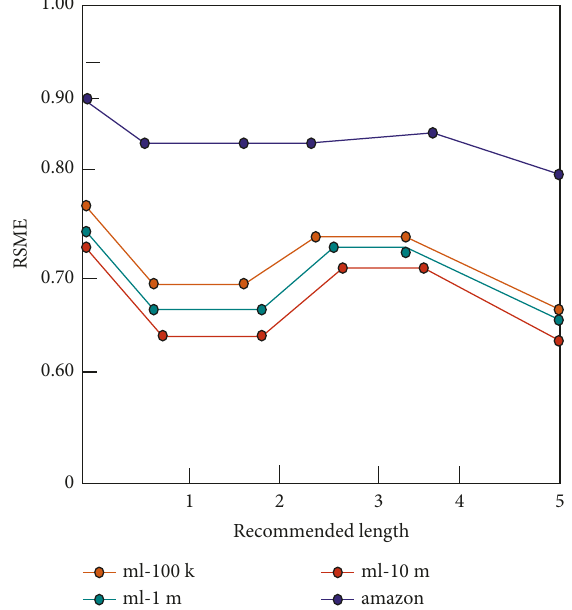
Figure 8: Effect of the number of hidden layers on RMSE.